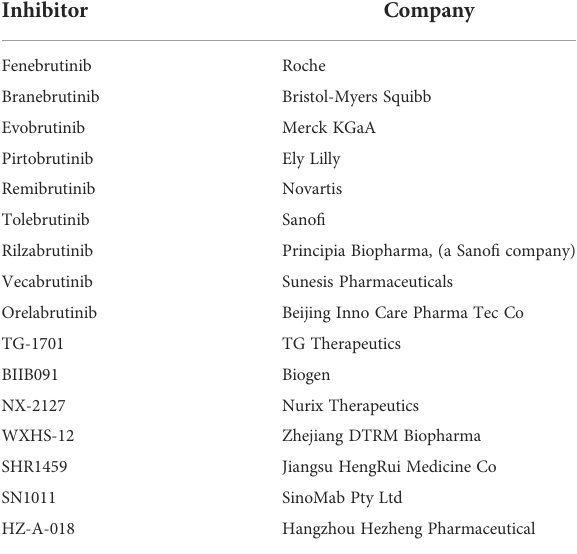
TABLE 2 BTKis in clinical trial (as of April 2022, clinicaltrials.gov).